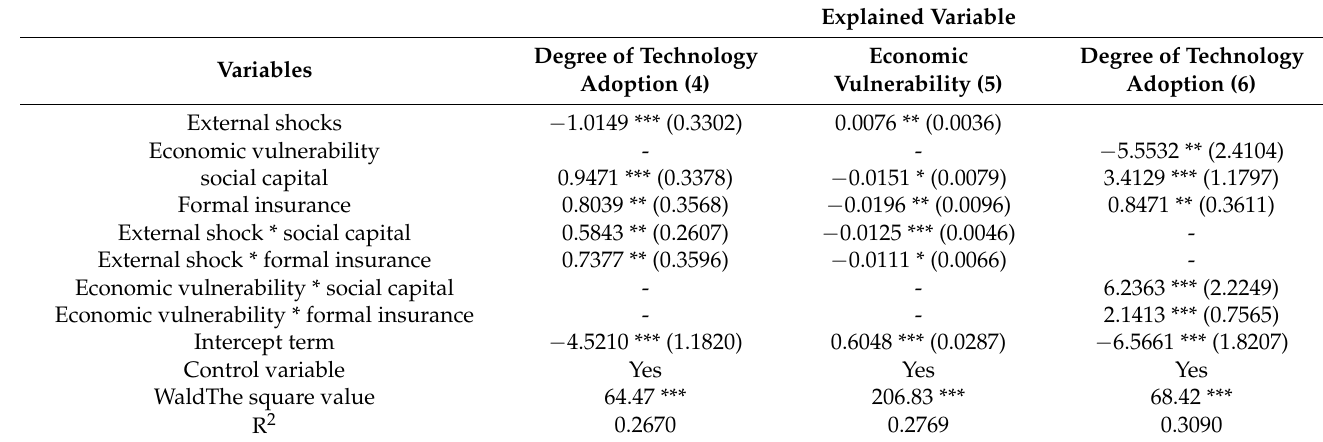
Table A3. Robustness test of the moderator